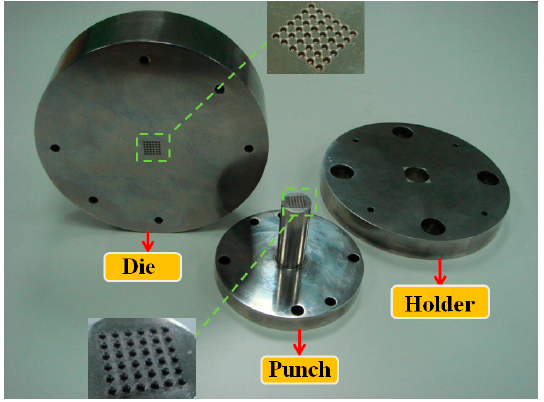
Figure 6. The prototype of tools for the micro-channel array forming process.